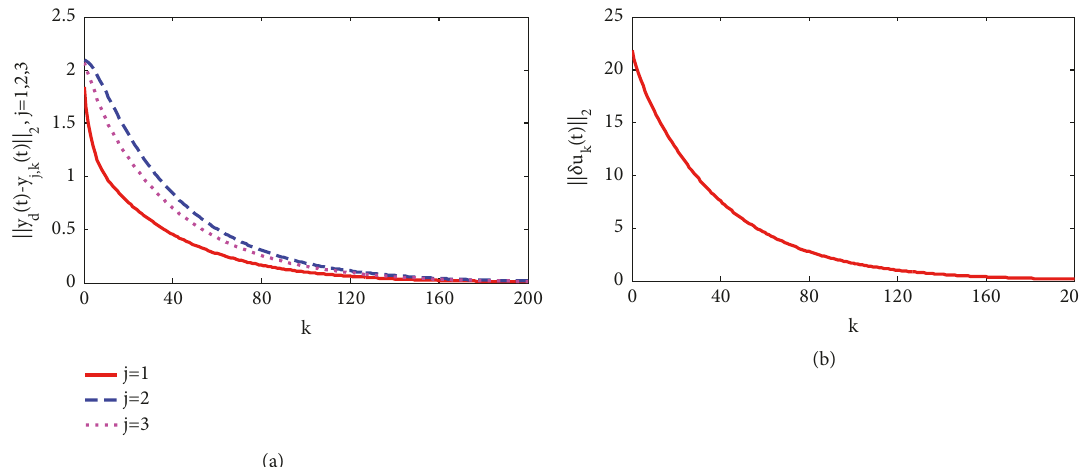
Figure 2: Under the observer (6) and the controller (11) with 𝐾 = [0.0748,0.0931] and Γ = [−0.0034,0.1496] : (a) Output tracking errors versus iteration numbers; (b) input errors ‖𝛿𝑢 𝑘 (𝑡)‖ 2 versus iteration numbers (color online).